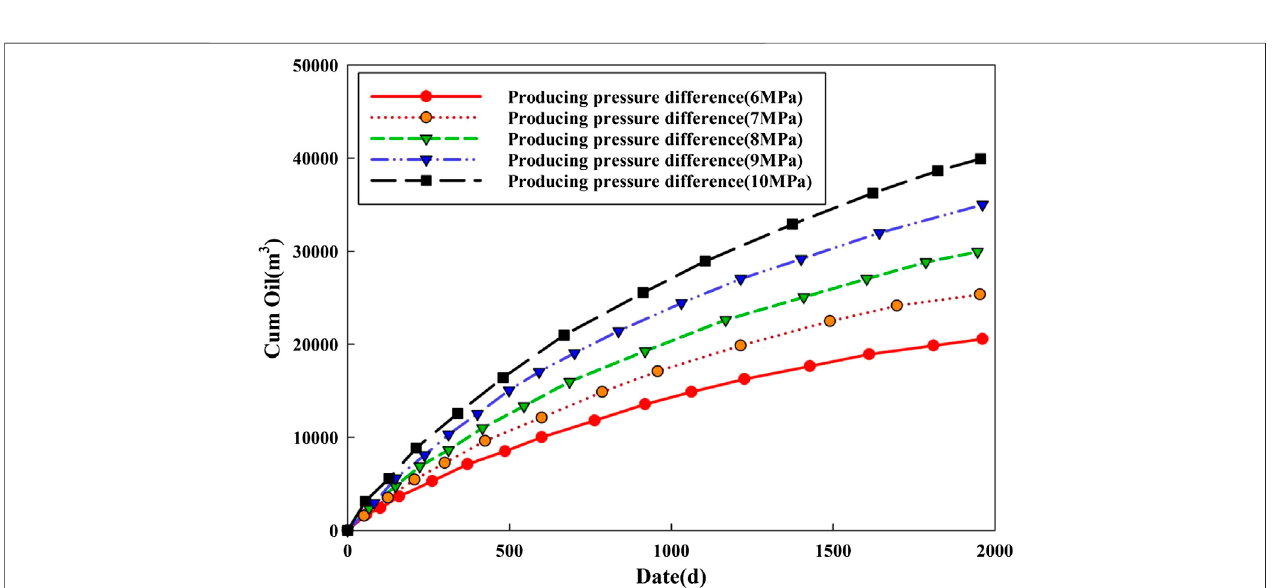
FIGURE 10 | Cumulative oil production curve of different producing pressure